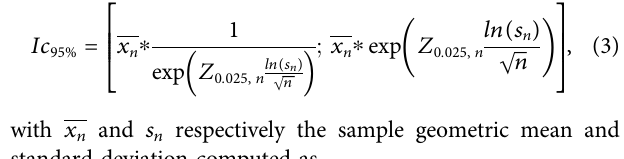
Frontiers in Earth Science |